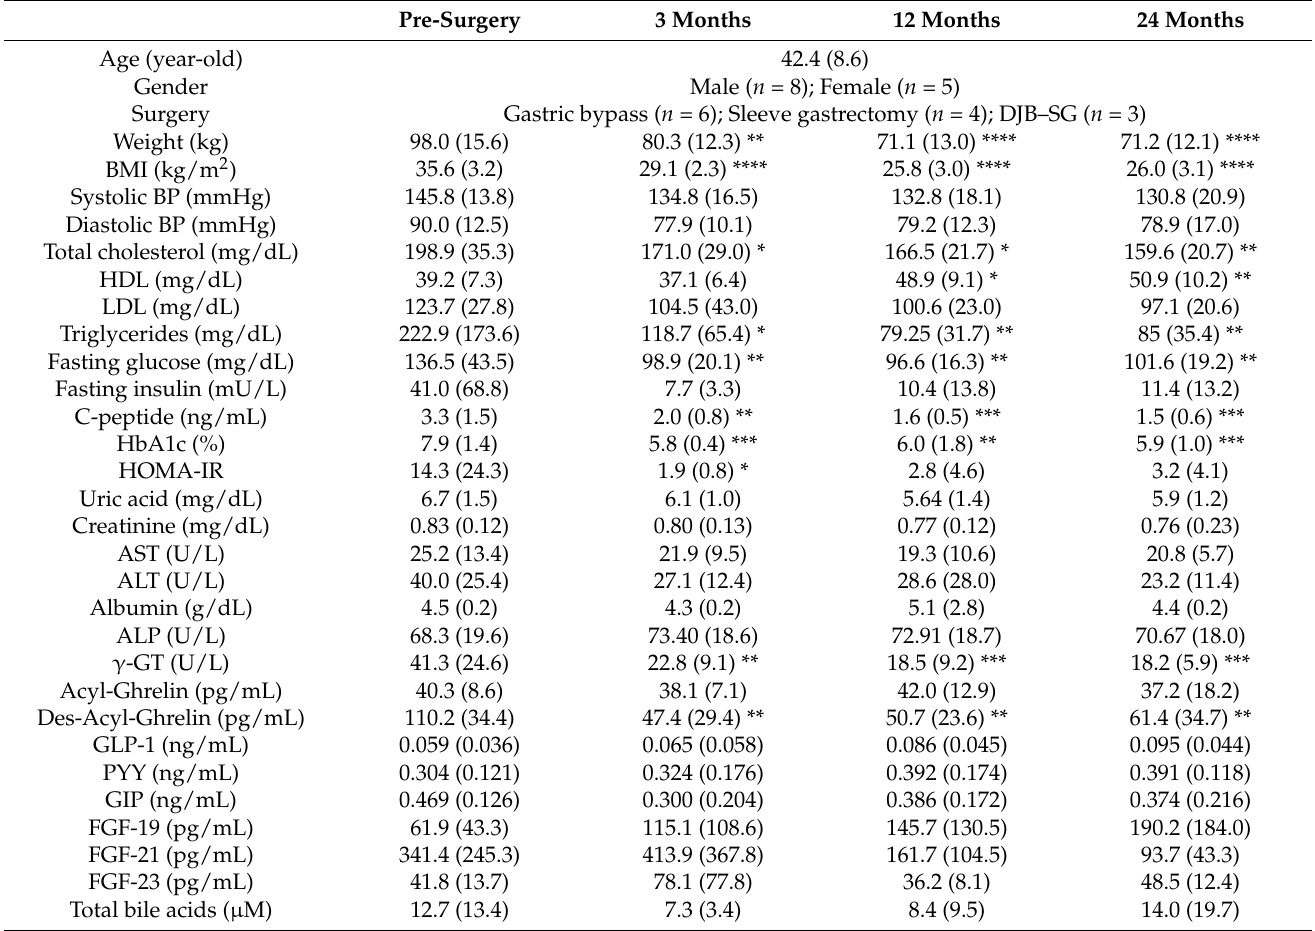
Table 1. Effect of metabolic surgery on clinical and circulating biomarkers for patients.